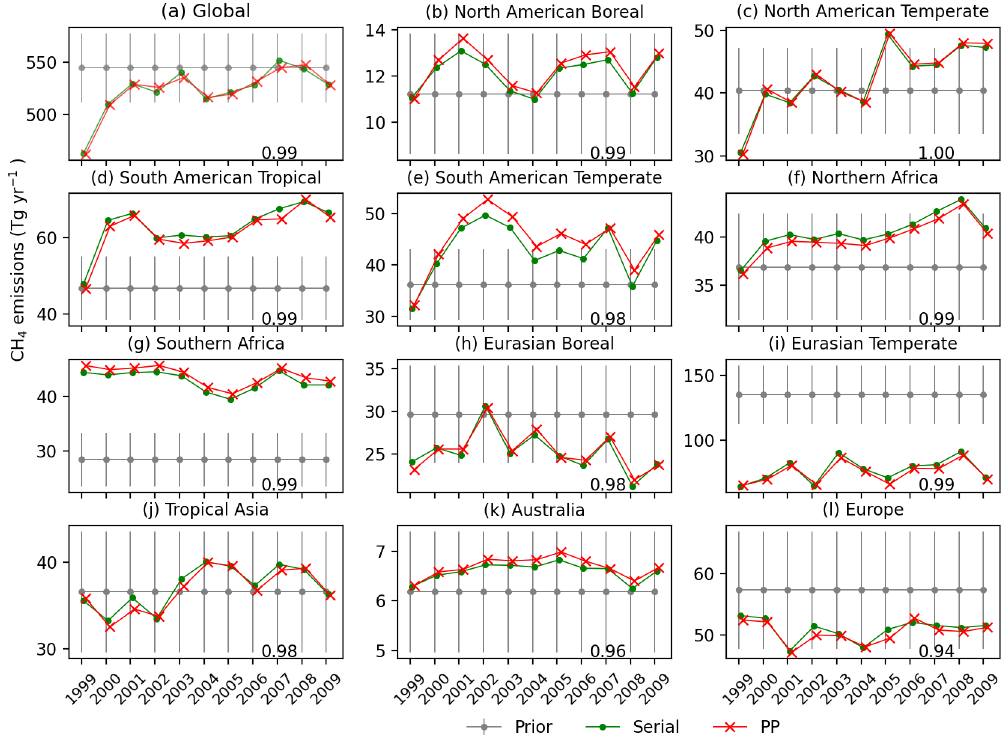
Figure 6. Annual methane emission estimates from the PP and serial inversions for the globe and the TRANSCOM regions. The vertical bars show the ± 2 σ uncertainties of the prior emissions. The correlation coefficients of PP and serial time series are given at the bottom of each